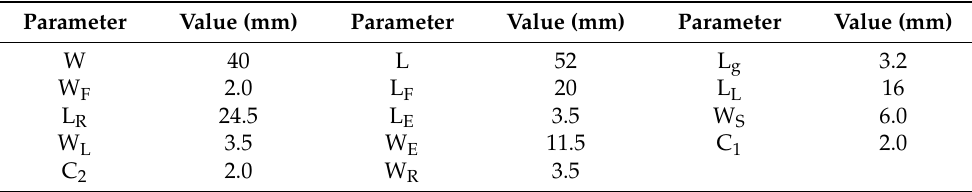
Table 1. Optimized dimension parameters and their values.